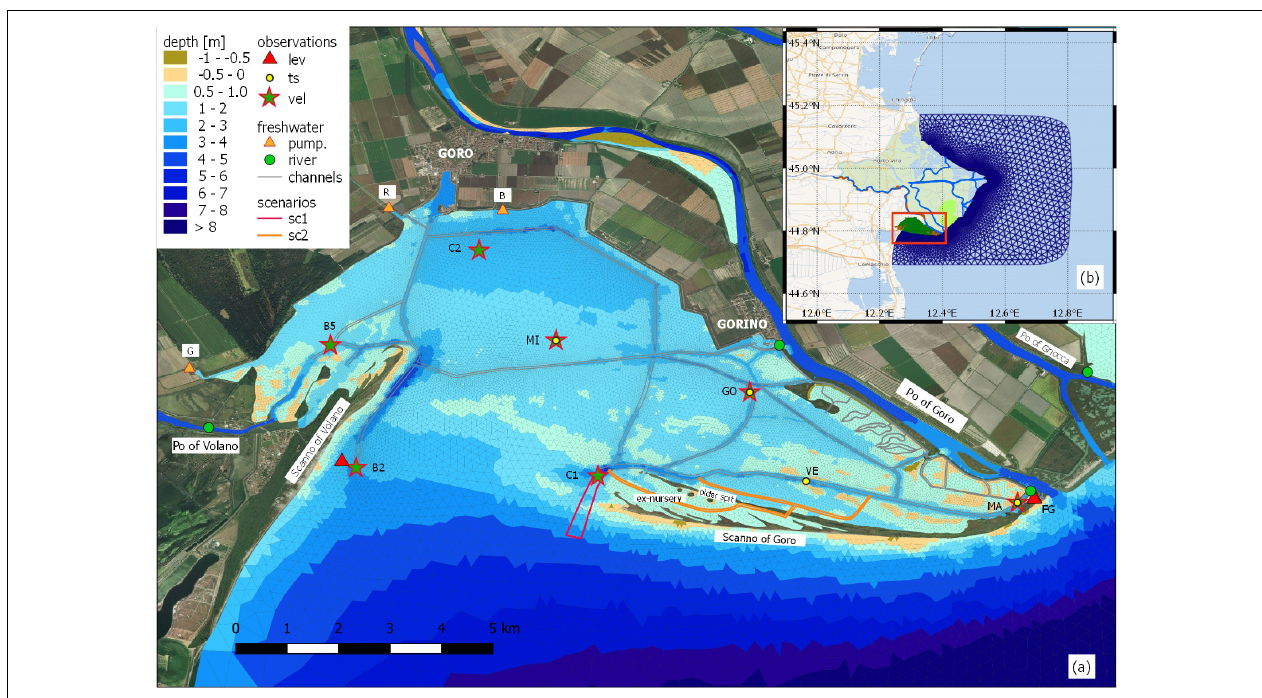
FIGURE 1 | (A) Bathymetry of the triangular grid of the Goro Lagoon. In the upper panel (B) , the grid extension of the model surrounding the Po river delta in the Northern Adriatic Sea. The pumping stations are: Giralda (G), Romanina (R), and Bonello (B). Station’s names are: Manufatto (MA), also a river connection (green point), Faro di Goro (FG), Venus (VE), Gorino (GO), nearby the Gorino lock (green point), Mitili (MI), Spiaggina di Goro (C2), western inlet channel (B2), and eastern inlet channel (C1). The Scanno of Goro is the most recent seaward spit that started to grow after 1991. The older spit is still present, but internal to the lagoon. The stars represent the points where the current meters were installed alone, CTD are indicated with the yellow dots. The background cartography comes from the Bing Aerial dataset for (A) and Wikimedia dataset for (B) .